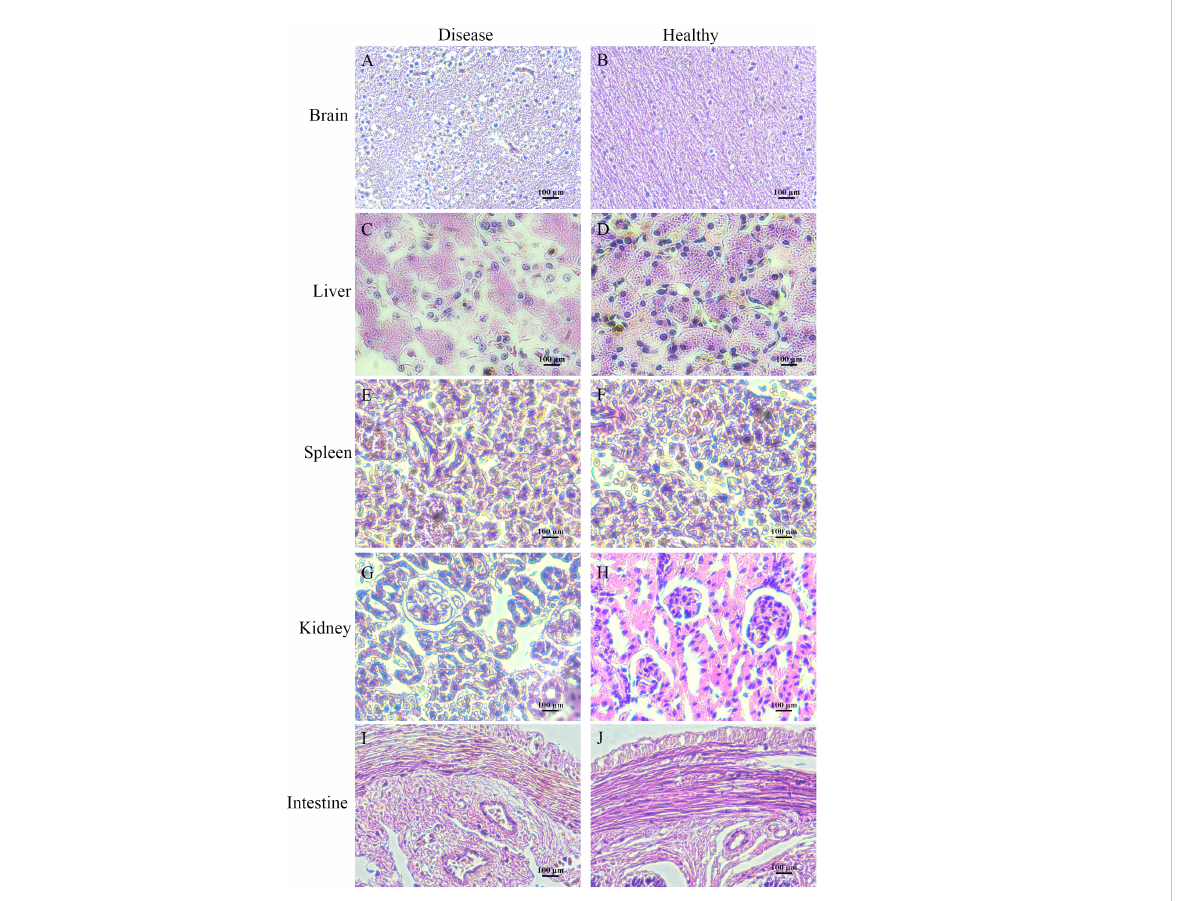
FIGURE 6 Histologically diseased bullfrog liver (C) , spleen (E) , kidney (G) , intestine (I) , and brain (A) were observed in comparison with tissue sections of healthy bullfrog liver (D) , spleen (F) , kidney (H) , intestine (J) , and brain (B) , where the most obvious signs of brain injury are ventricular thickening, membranous tissue degeneration, and a sharp increase in glia, showing the pathological changes typical of encephalitis and